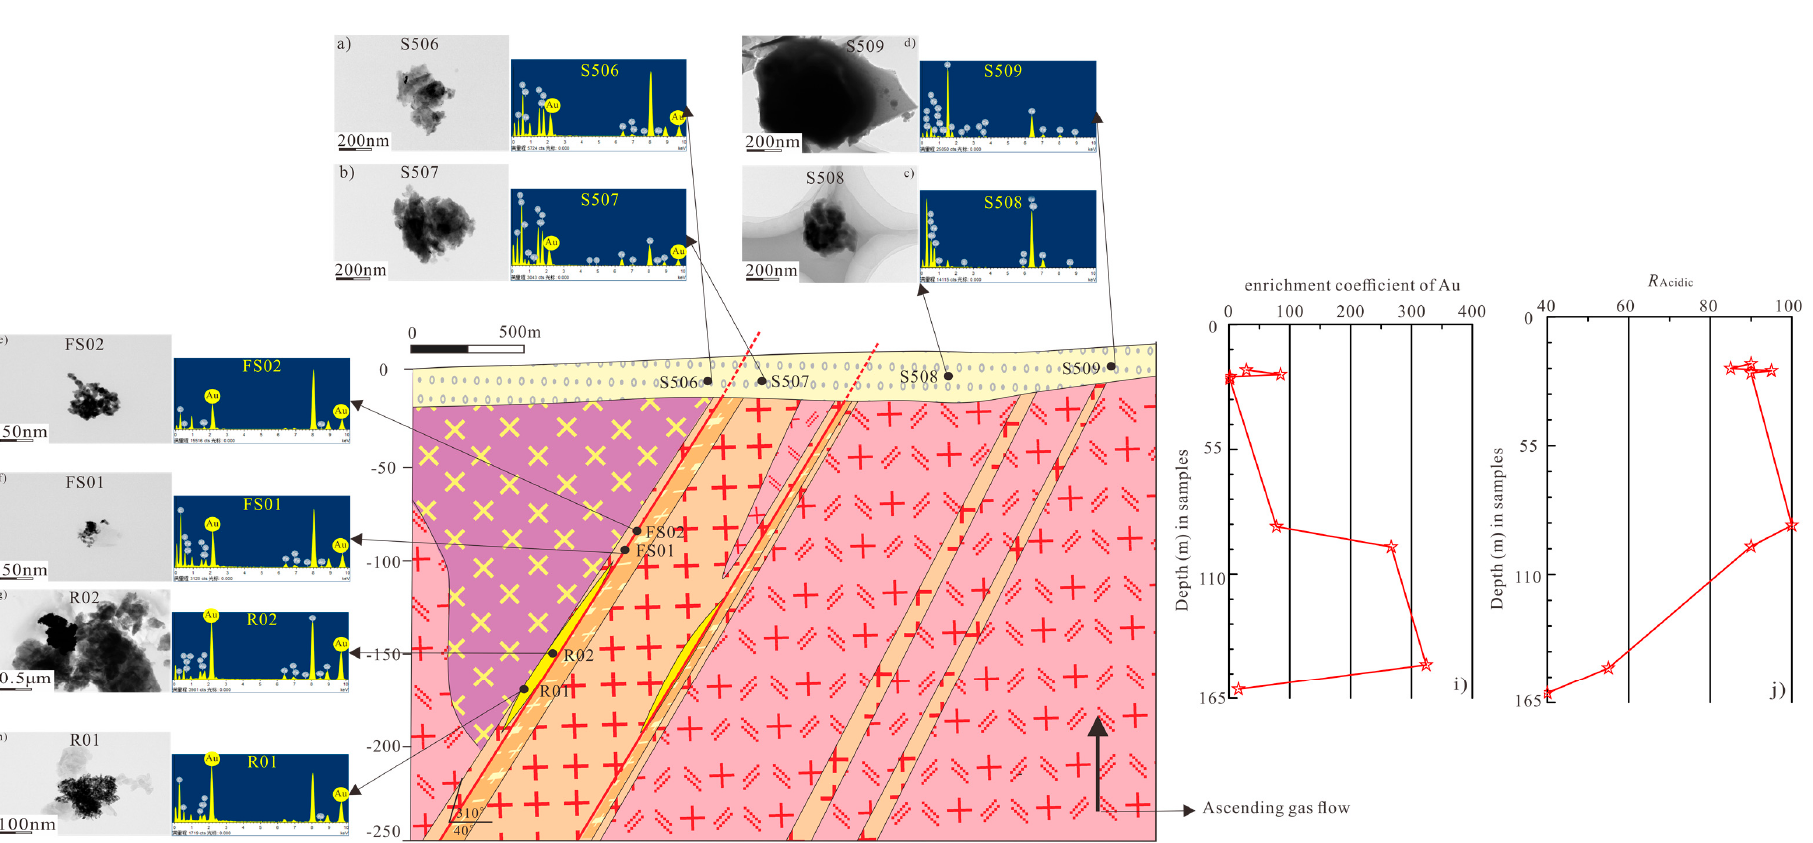
Figure 3. Schematic diagram of the migration model of the metal-bearing nanoparticles. ( a , b )—the TEM image of Au particles and the energy spectrum of the soils S506, S507 above the ore body; ( c , d )—the TEM image and the energy spectrum of the soil samples S508, S509 away from the ore body; ( e , f )—the TEM image of Au particles and the energy spectrum of the fault muds FS02, FS01 above the ore body; ( g , h )—the TEM image of Au particles and the matching energy spectrum of ores R02, R01; ( i )—enrichment coefficients of Au in different samples; ( j )—gene similarities of different